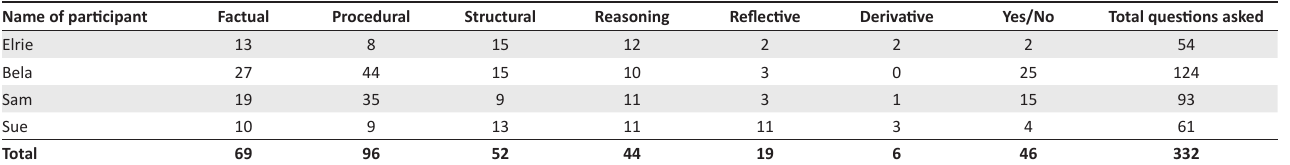
TABLE 2: Categories of questions asked by four teachers in 12 lessons. Name of participant